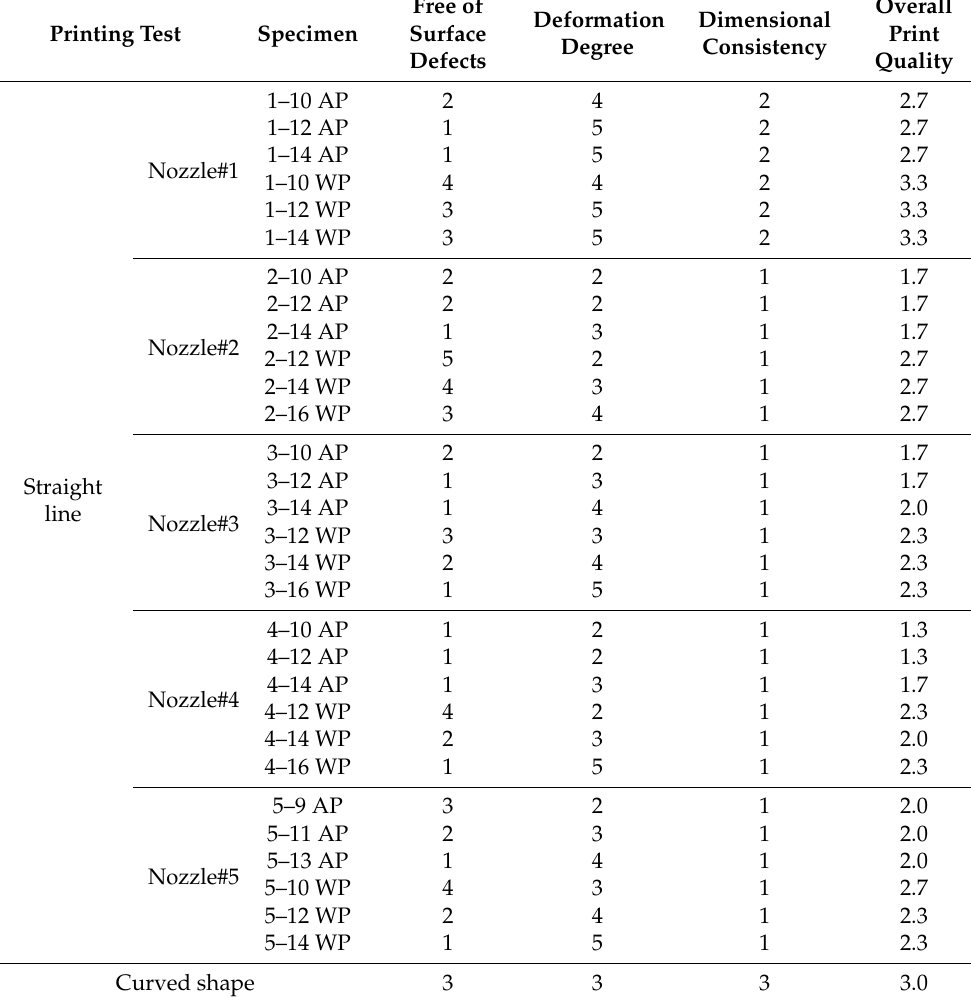
Table 4. Evaluation of printing